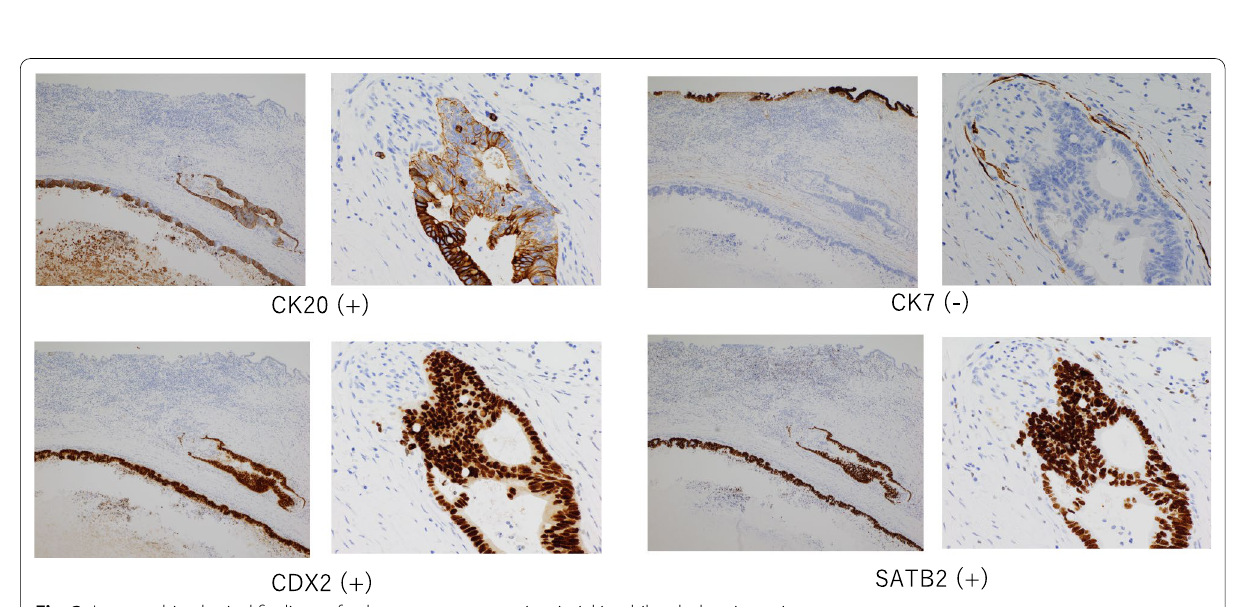
Fig. 3 Immunohistological findings of colon cancer metastasis mimicking hilar